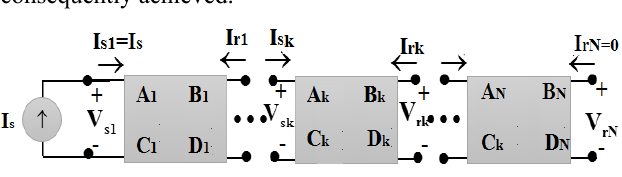
Figure 4: Cascade connection of two-port networks for figure